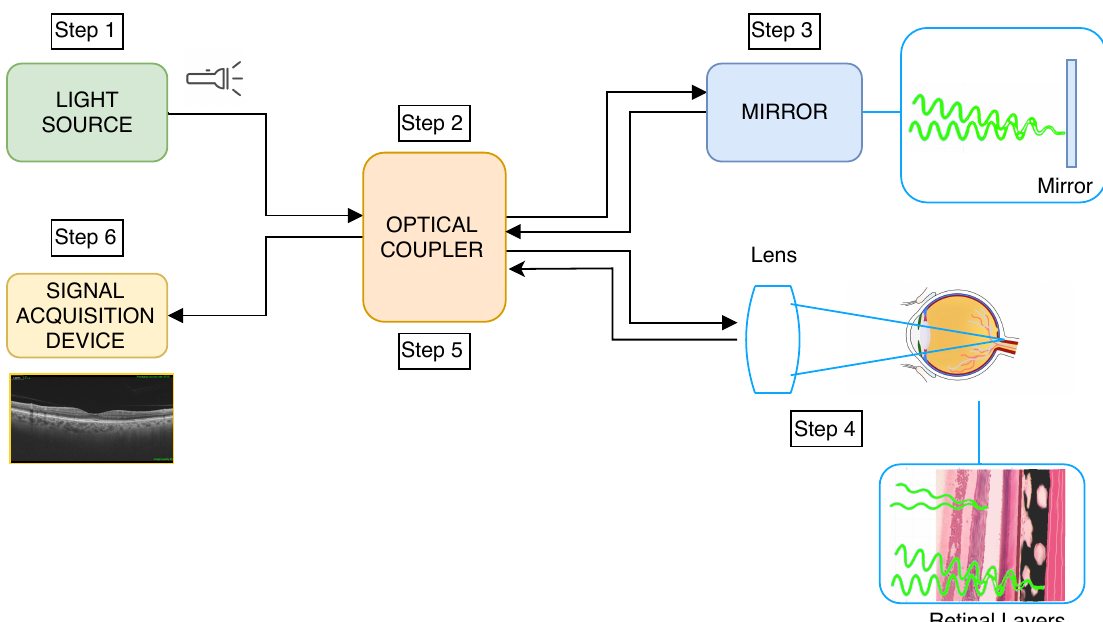
Figure 2. Graphical scheme of the Optical Coherence Tomography (OCT) image acquisition